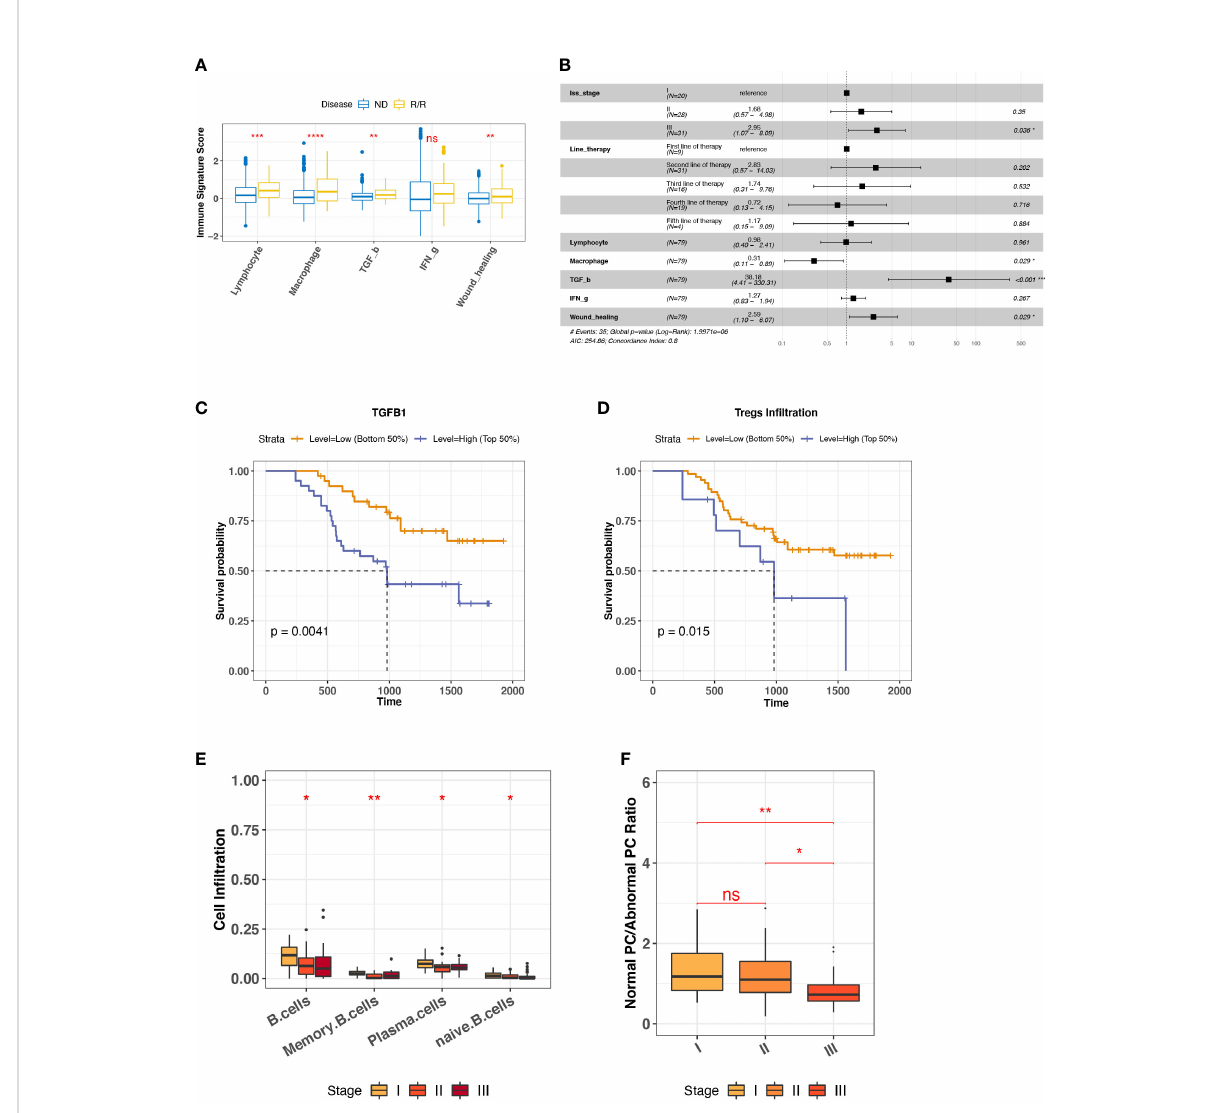
FIGURE 2 Biomarkers for R/R MM prognosis. (A) Comparison of representative immune signature score between ND and R/R MM tumors. Asterisks denote signi fi cance level (**** P < 0.0001; *** P < 0.001; ** P < 0.01; * P < 0.05; NS, not signi fi cant, P > 0.05). (B) Forest plot for cox proportional hazard model with representative immune signatures corrected by line therapy and tumor stage. (C) Kaplan – Meier survival curve for TGFB1 expression. Two groups are de fi ned by median expression of TGFB1. (D) Kaplan – Meier survival curve for Treg cell in fi ltration. Two groups are de fi ned by median in fi ltration level of Treg cells. (E) B-cell lineage in fi ltration comparison across different tumor stages. Asterisks denote signi fi cance level (*** P < 0.001; ** P < 0.01; * P < 0.05; NS P > 0.05). (F) Ratio of normal PC to abnormal PC comparison across different tumor stages. Asterisks denote signi fi cance level (*** P < 0.001; ** P < 0.01; * P < 0.05; NS P > 0.05). ns, Not signi fi